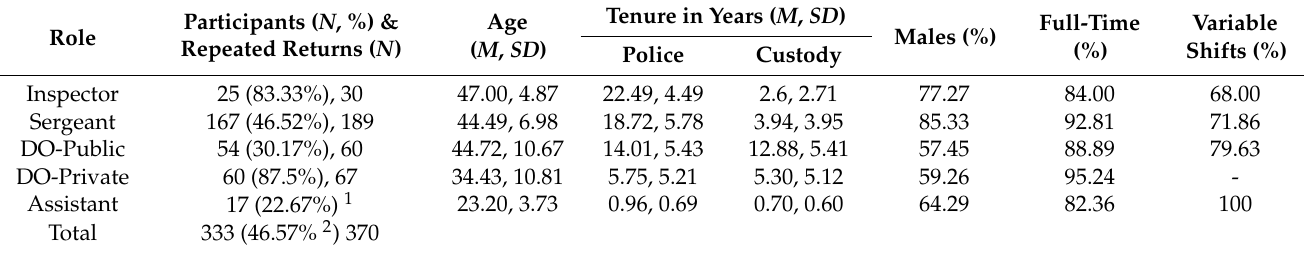
Table 1. Participant